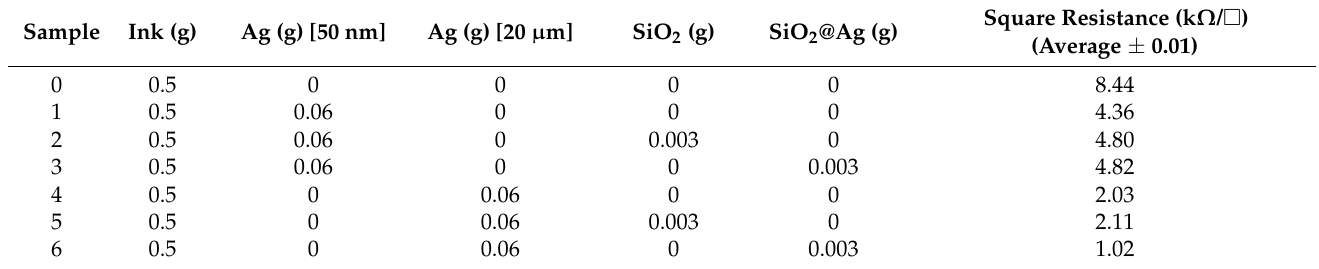
Table 1. Modified components of 3CI and the corresponding electrical properties (Unit: k Ω / □ ).